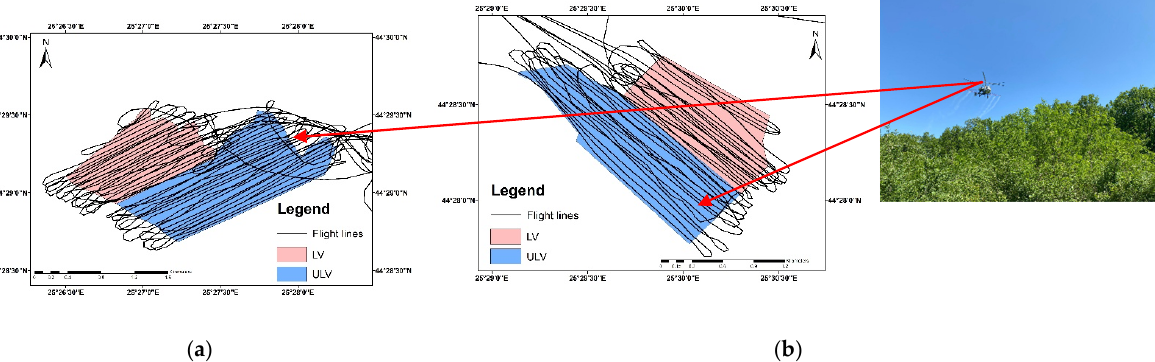
Figure 2. Analysis of the flight routes recorded by the GPS device in ( a ) Forest A (contact insecticide) and ( b ) Forest B (systemic insecticide).